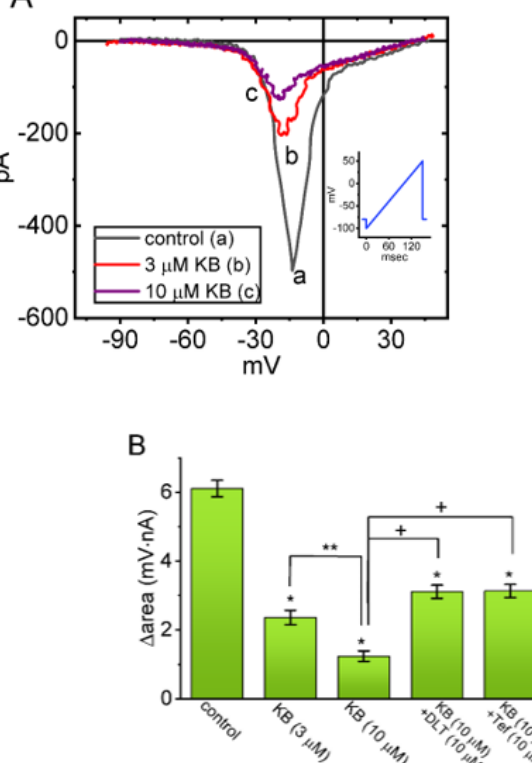
Figure 4. Inhibitory effect of KB-R7943 on nonlinear window I Na ( I Na(W) ) activated by abrupt as- cend − ng ramp voltage (V ramp ) in GH 3 cells. This set of whole − cell current recordings was undertaken with the tested cell voltage-clamped at − 80 mV, and we then applied V ramp from − 100 to +50 mV for a duration of 150 ms on the cell. ( A ) Exemplar current traces were acquired during the control period (a, black color) and in the presence of 3 μM KB - R7943 (b, red color, KB) or 10 μM KB − R7943 (c, purple color, KB). The voltage clamp protocol applied is shown in the inset, whereas a downward deflection is indicated as the appearance of transient inward current (i.e., instantaneous I Na(W) ) in response to short ascending V ramp . ( B ) Summary bar graph showing the effect of KB − R7943 (KB, 3 or 10 μM), KB -R7943 plus deltamethrin (DLT), and KB − R7943 plus tefluthrin (Tef) on the ∆area of I Na(W) (mean ± SEM; n = 8 for each green bar) . The ∆area of I Na(W) (i.e., the relationship of membrane voltage versus current amplitude) was calculated at the area encircled under the voltages ranging between − 90 and +40 mV during the short upsloping V ramp . * Significantly different from control ( p < 0.05), ** significantly different from KB- R7943 (3 μM) alone group ( p < 0.05), and + significantly different from KB − R7943 (10 μM) alone group ( p < 0.05).